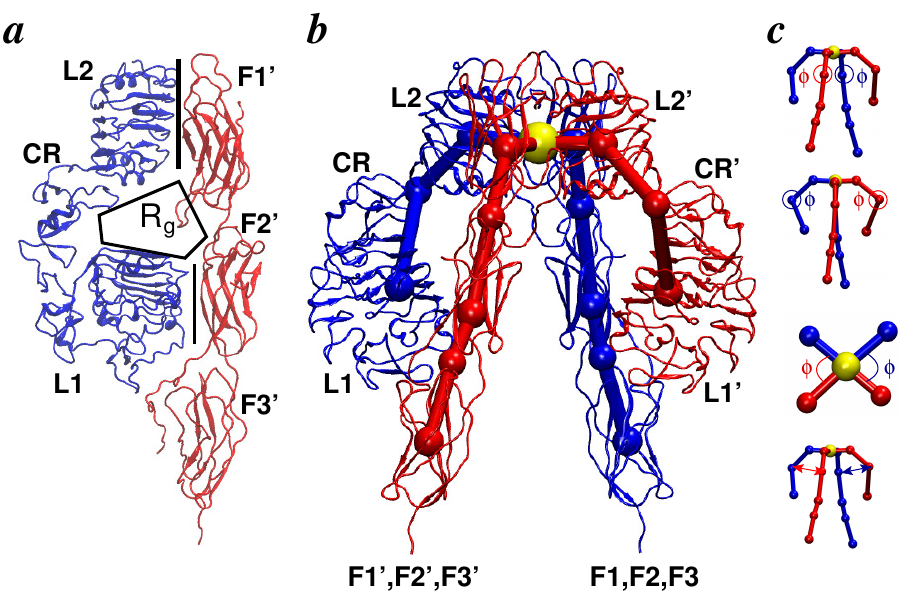
Figure 4. Conformational metrics of receptors. ( a ) Schematic illustration of a side view of the IR ectodomain. The binding pocket (indicated by R ) is formed by the L1-CR-L2 g motif of one subunit (blue) and the F1-F2-F3 motif of the other subunit (red). The L2-F1 (cid:48) and L1-F2 (cid:48) interfaces are indicated by vertical lines; line thickness indicates higher/lower buried surface area; ( b ) Overlay of mapping points on the crystallographic conformation of the IR ectodomain. Each subunit is conceptualized as a linear chain of eight mapping points (indicated by spheres) with an additional mapping point (yellow sphere) joining both subunits at the apex. Each mapping point corresponds to either the center-of-mass of a domain or an interdomain hinge; ( c ) Hinge angles (F1-F2, L1-L2 and L2-F1) are indicated ( top ), and the interhinge distances between the L1-L2 and F1-F2 hinge points are also shown ( bottom